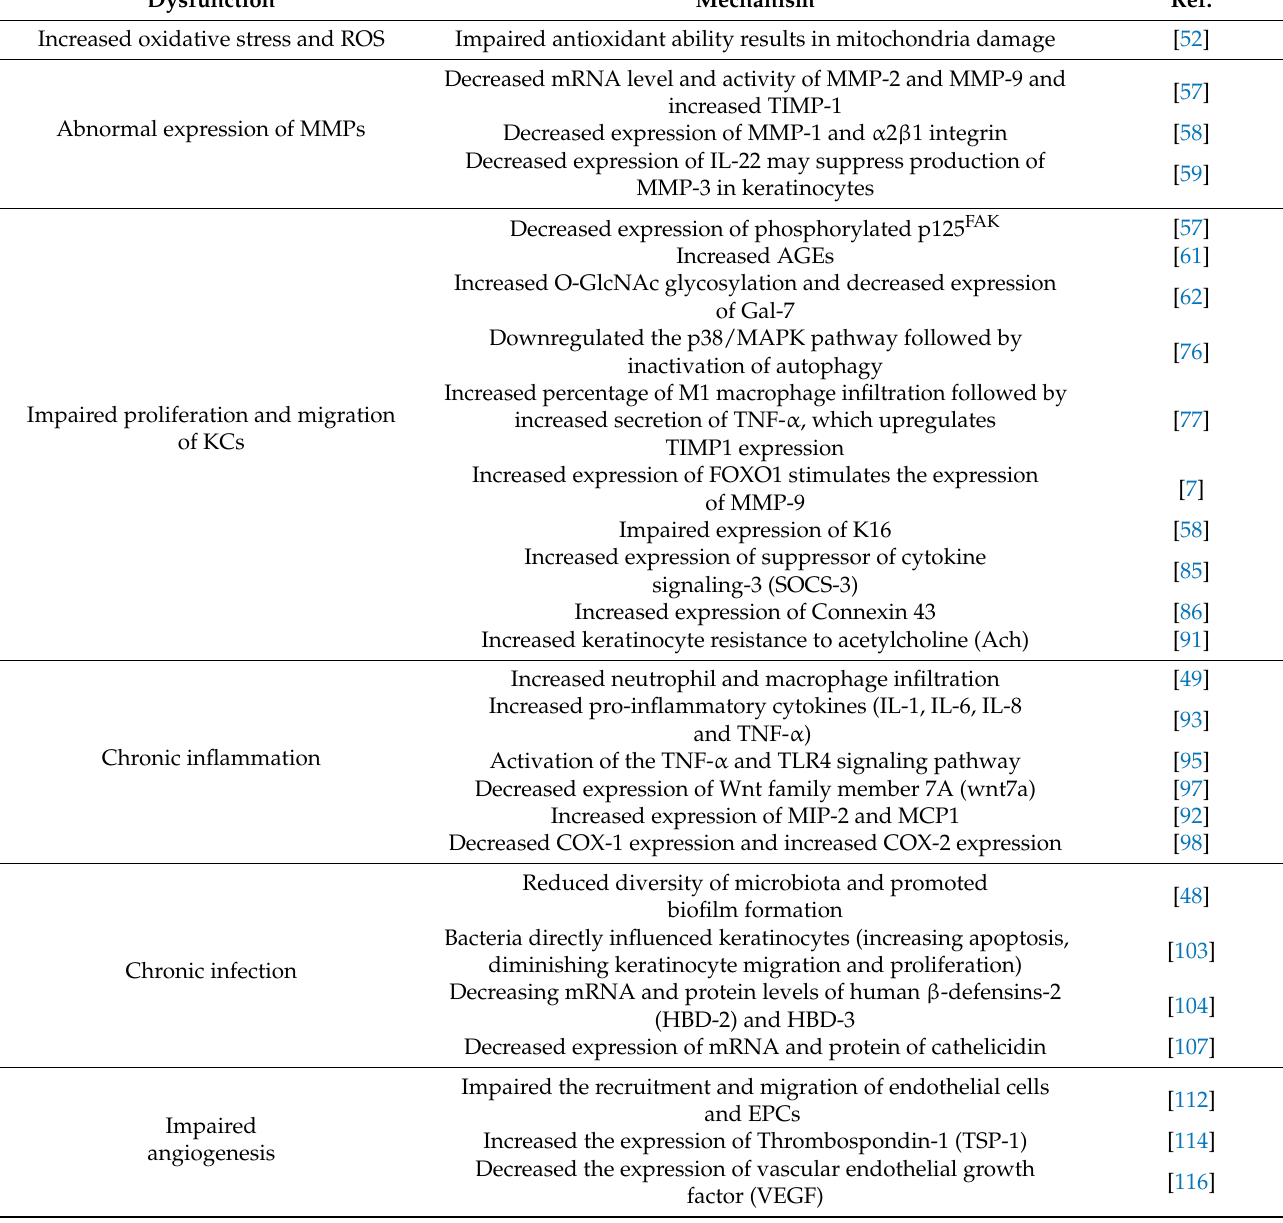
Table 1. Various mechanisms related to dysfunctional keratinocytes in diabetic wound healing.